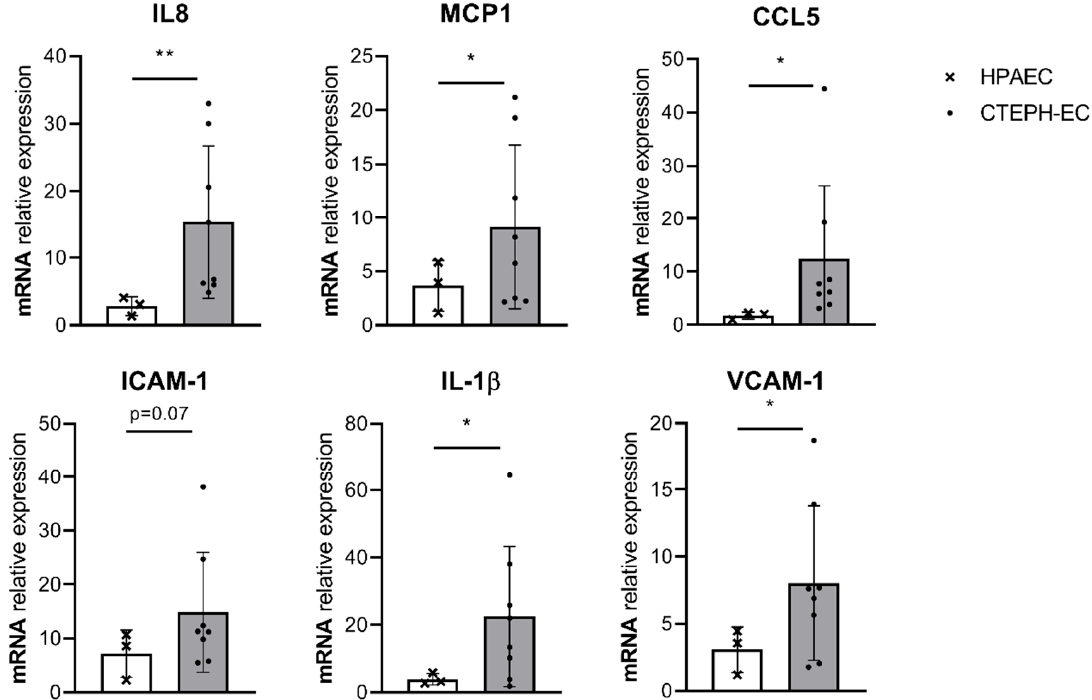
Figure 1. Basal inflammatory gene expression in cultured CTEPH endothelial cells (ECs). mRNA expression levels of interleukin (IL)-8, IL-1 β , monocyte chemoattractant protein- 1 (MCP-1), C-C motif chemokine ligand 5 (CCL5), vascular cell adhesion molecule-1 (VCAM-1), and intracellular adhesion molecule-1 (ICAM-1) were found increased under basal conditions (0.1 serum) in CTEPH-ECs compared to human pulmonary artery endothelial cells (HPAECs). CTEPH-EC, n = 8 donors; HPAEC, n = 3 donors; unpaired t-test with Welch’s correction, p < 0.05 = *, data are expressed as mean ± SD.